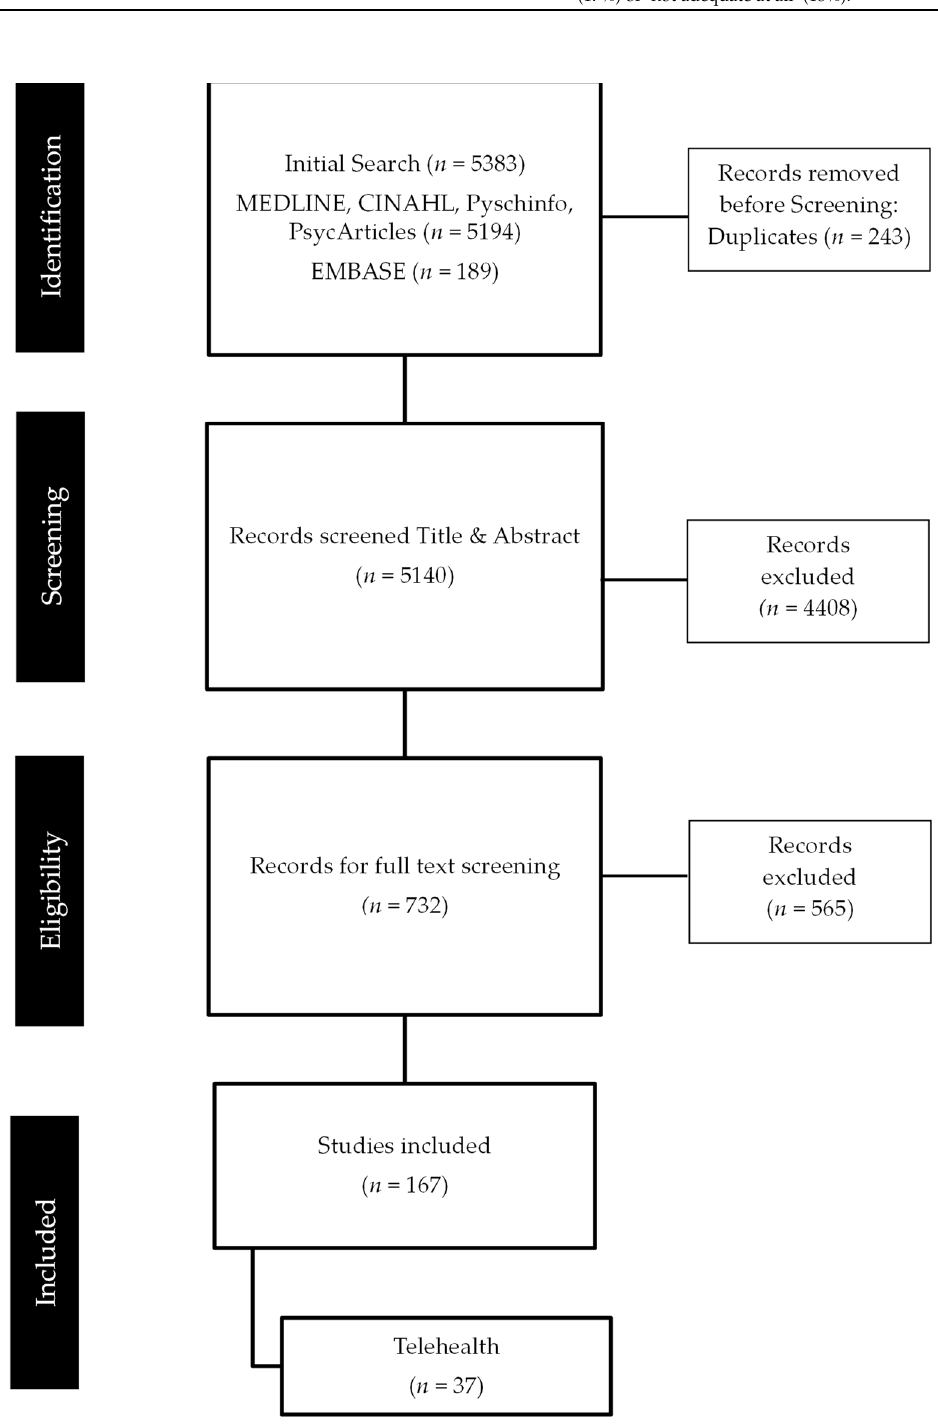
Figure 2. Search Figure 2. Search results. Table 2. Overview of Review Papers (See Appendix C for further information).